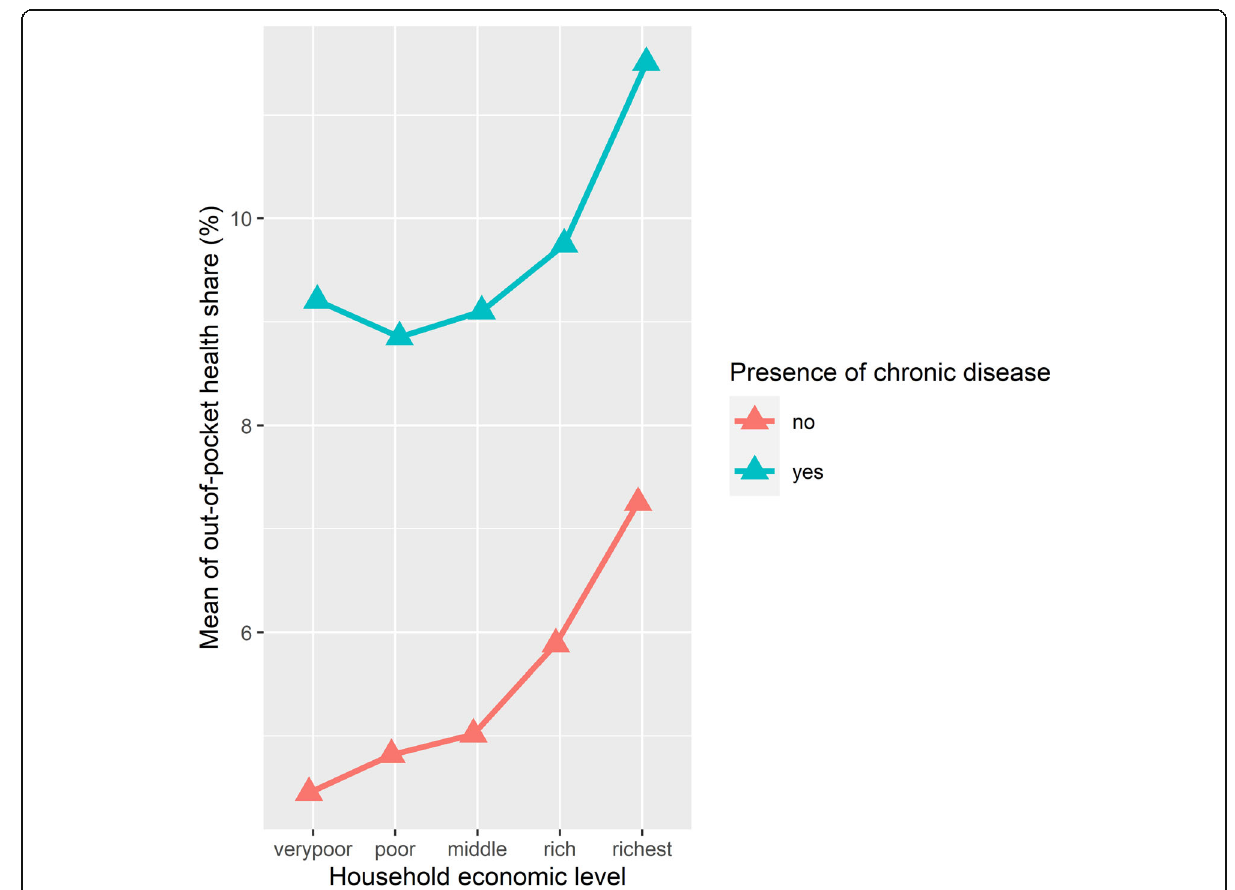
Fig. 6 The mean out-of-pocket health share according to the presence of chronic